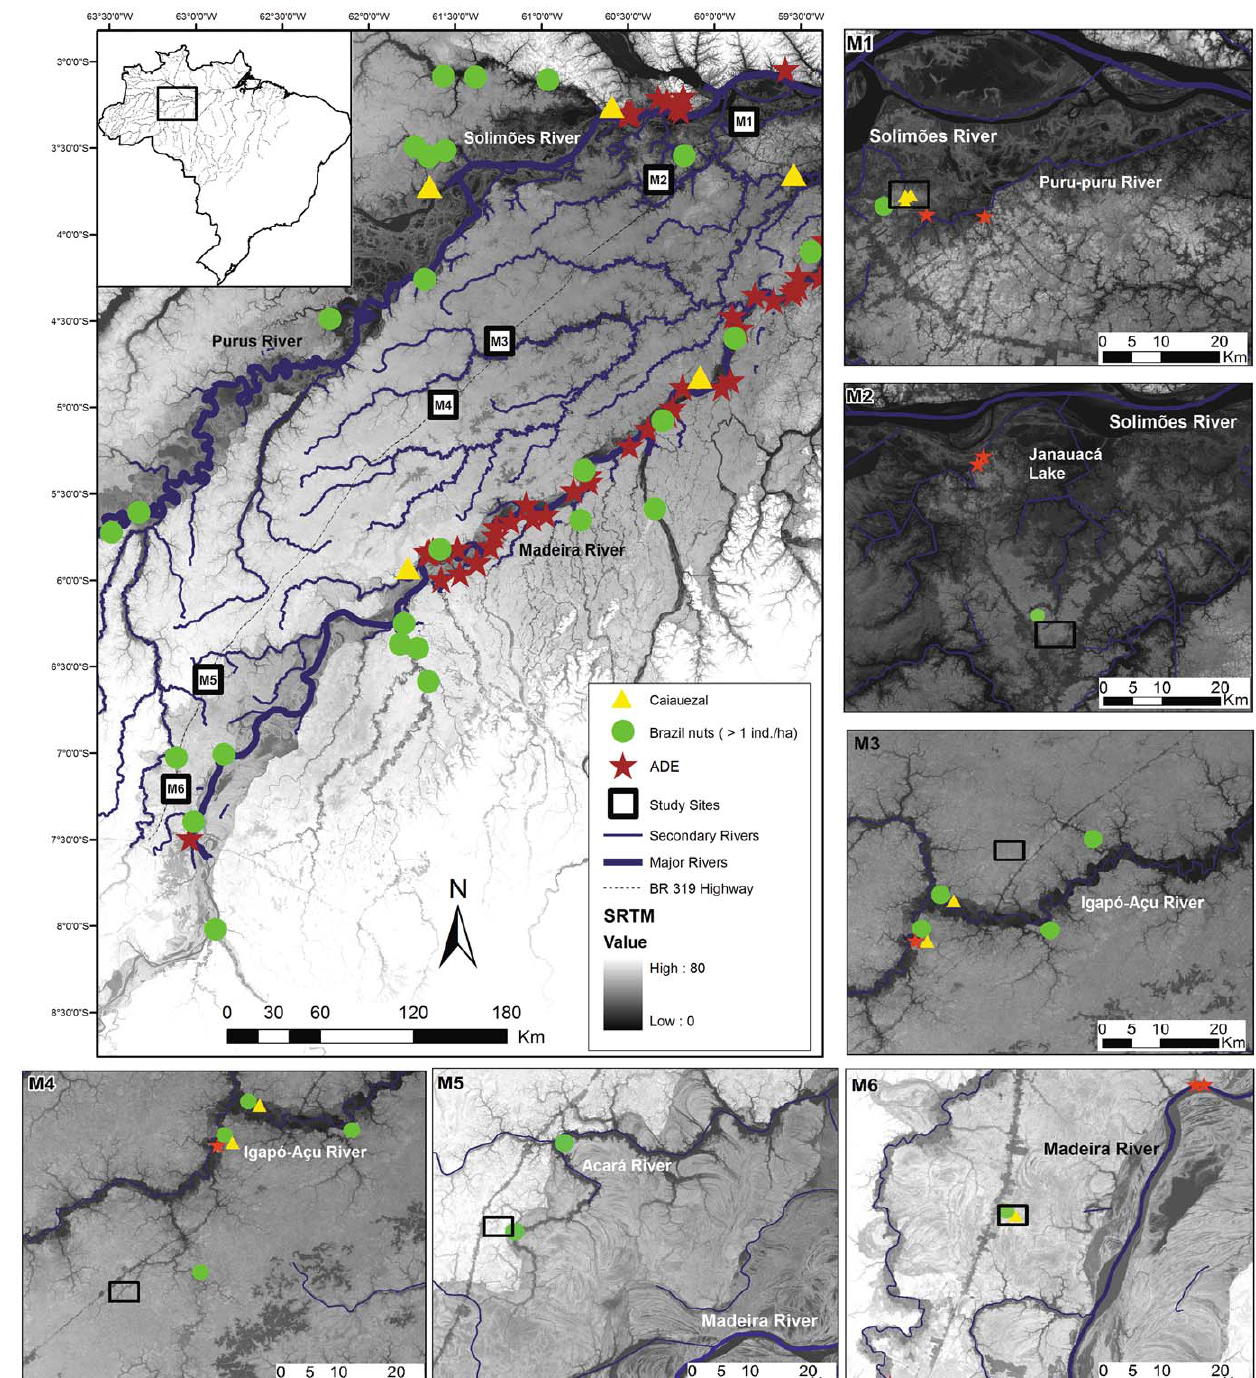
Figure 1. Map of the study area. The large map shows the central-northern Purus-Madeira interfluve. The empty squares are the six sampling sites at different distances from major rivers. In each site, two plots were sampled for floristic analysis and five for charcoal analysis. Yellow triangles are caiauezais , green circles are castanhais (Brazil nuts . 1 individual/hectare) and red stars are ADE (Amazonian Dark Earth sites). ADE data from WinklerPrins and Aldrich [13], castanhais from RADAMBRASIL [24] and caiauezais from Moretzsohn et al. [25]. The other six maps show the newly identified Amazonian Dark Earth sites (ADE) and anthropogenic forests in the vicinity of each site, identified by interviews with local residents or by observation.